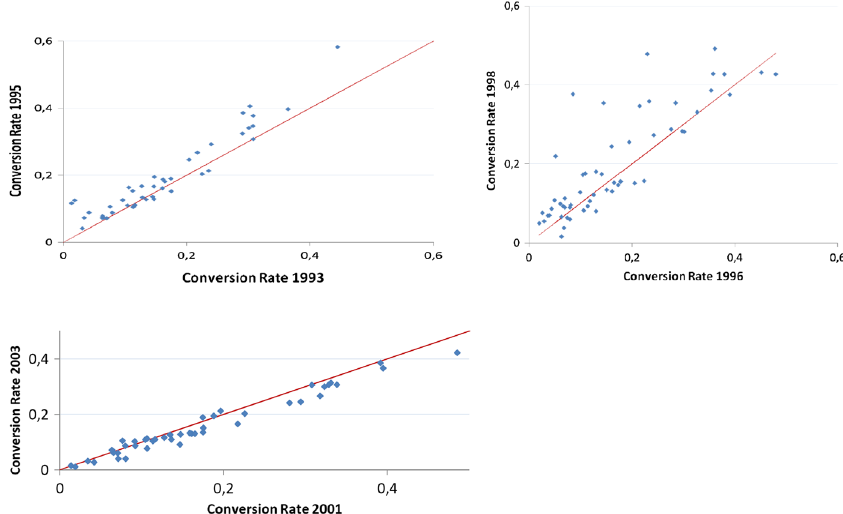
Fig. 3 Conversion rates before and after 1994, 1997 and 2002 EPL reforms